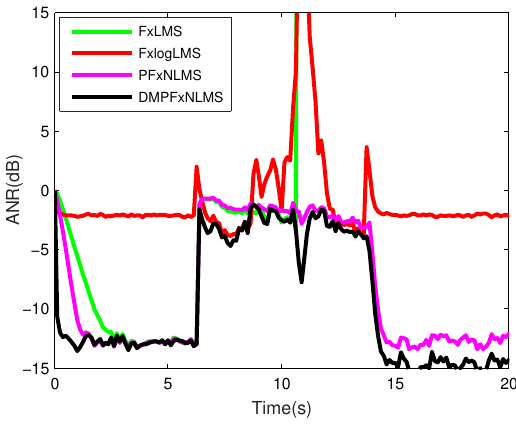
Figure 12. ANR performance comparison of the real-time